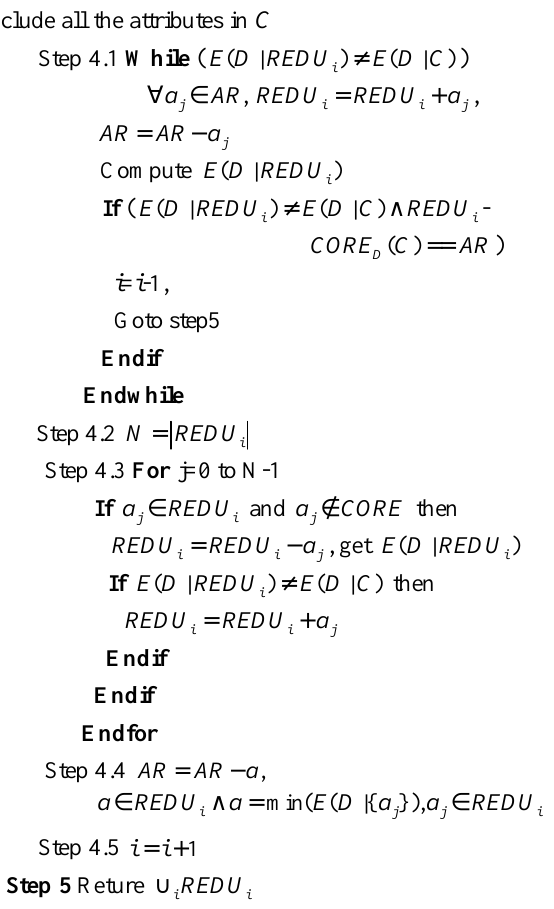
Algorithm 2 could find multiple reducts of a decision table. Therefore, all the candidate